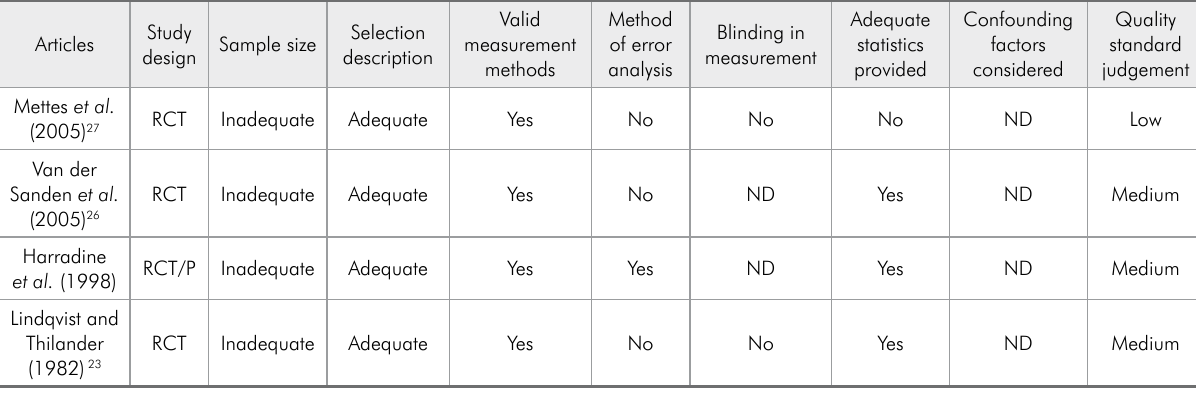
Table 4 - Quality evaluation of the studies retrieved.